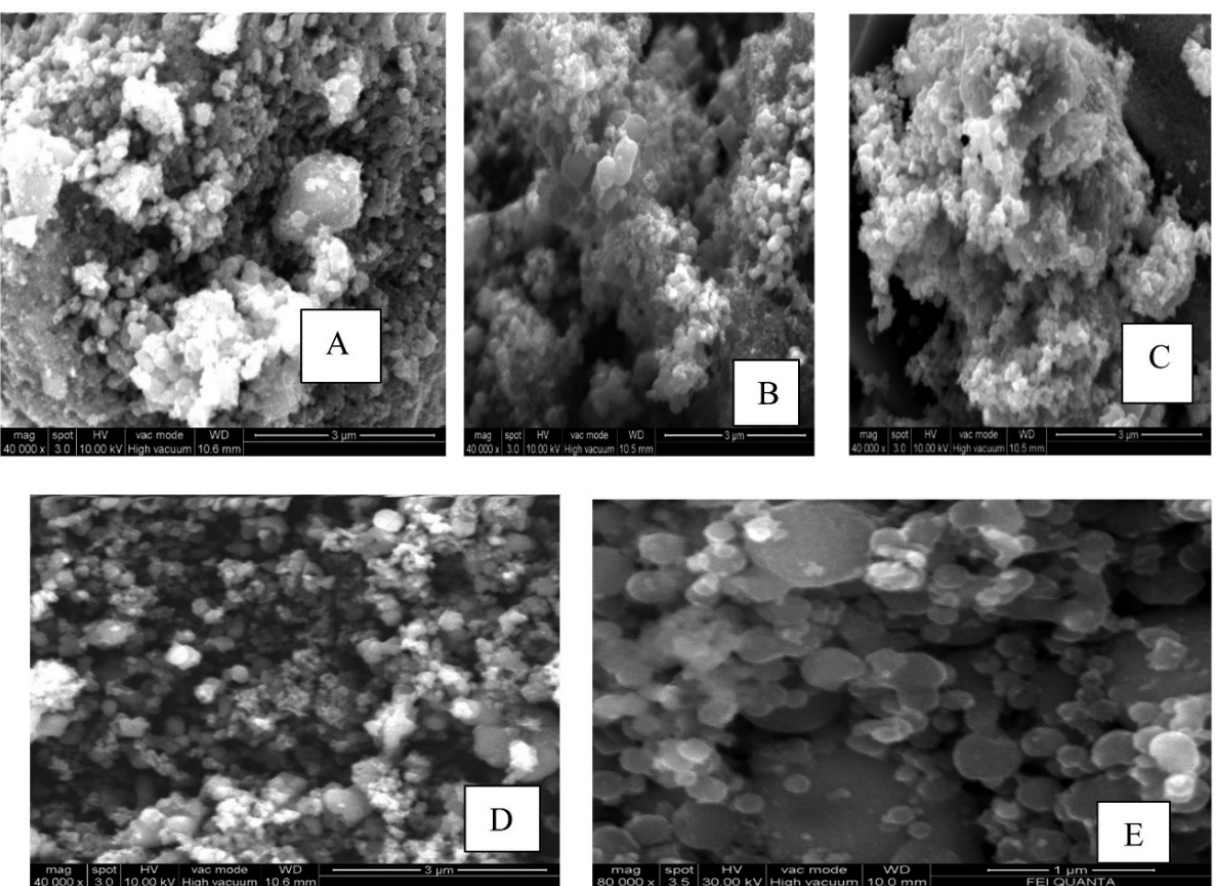
Figure 19. SEM images of ( A ) PB-TiO 2 , ( B ) OT-TiO 2 , ( C ) MO-TiO 2 , ( D ) CS-TiO 2 , and ( E ) TiO 2 . Reprinted from [67]. Table 2. A summary of synthesized TiO 2 nanostructures using green methods. Structural and Morphological Properties